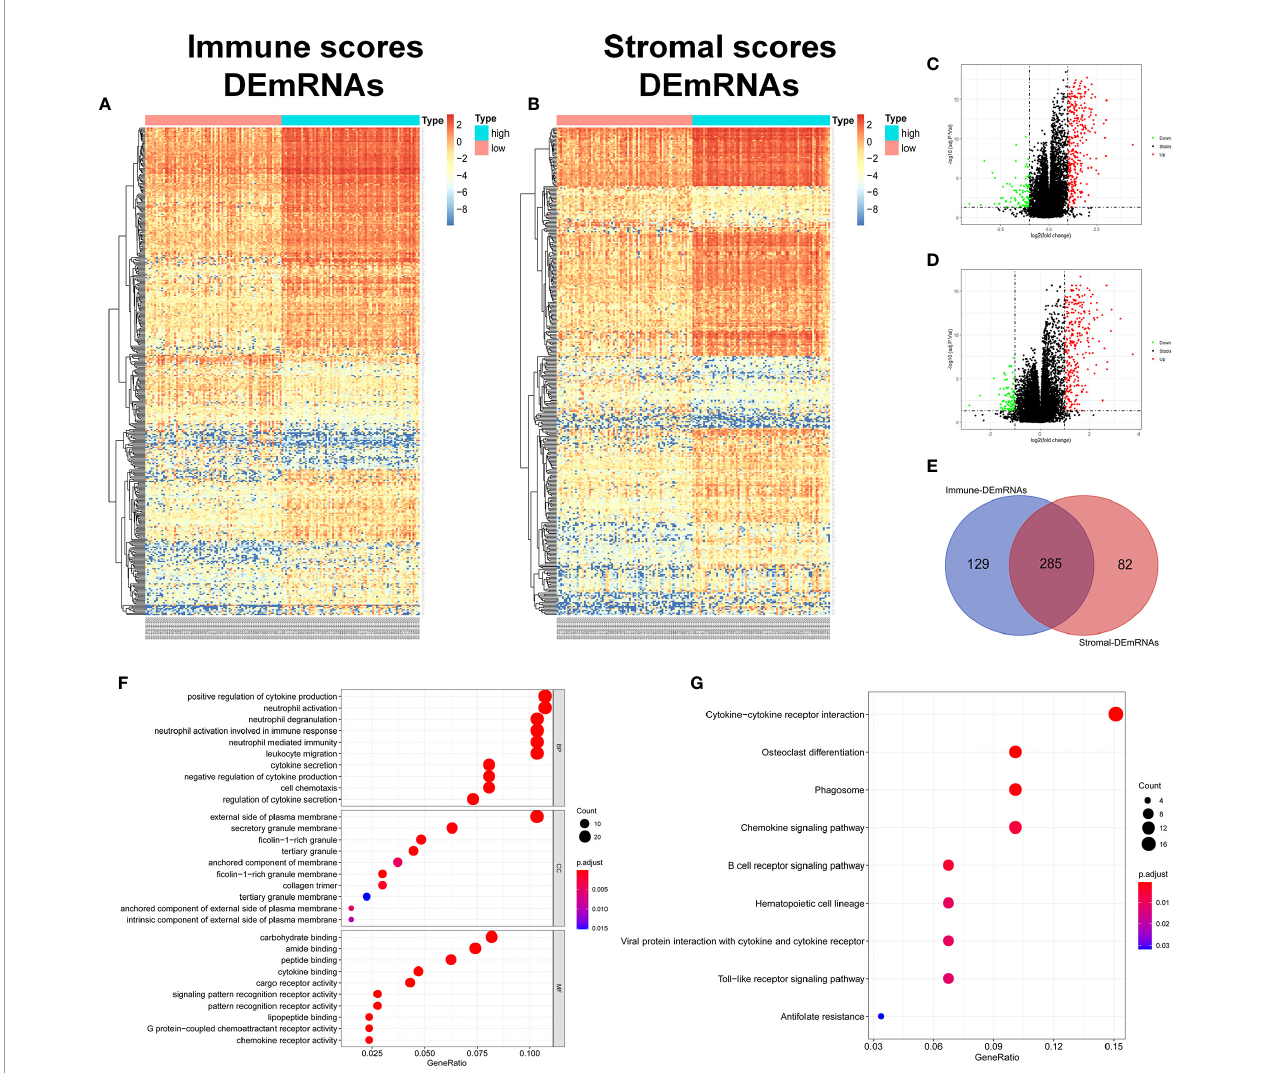
FIGURE 2 | Identi fi cation of TME-related mRNAs. (A) Heatmap of DEmRNAs between high and low immune groups. (B) Heatmap of DEmRNAs between high and low stromal groups. (C) Volcano map of mRNAs expression between high and low immune groups. (D) Volcano map of mRNAs expression between high and low stromal groups. (E) Venn diagram was used for the intersection of DEmRNAs within immune and stromal groups, we considered the common DEmRNAs to be TME-related mRNAs. (F) GO enrichment analysis was performed to annotate TME-related DEmRNAs: the larger the bubble and longer columns represent the more genes enriched in this function, the deeper the color of the bubble and bars, the smaller the P value. (G) TME-related DEmRNAs KEGG enrichment analysis